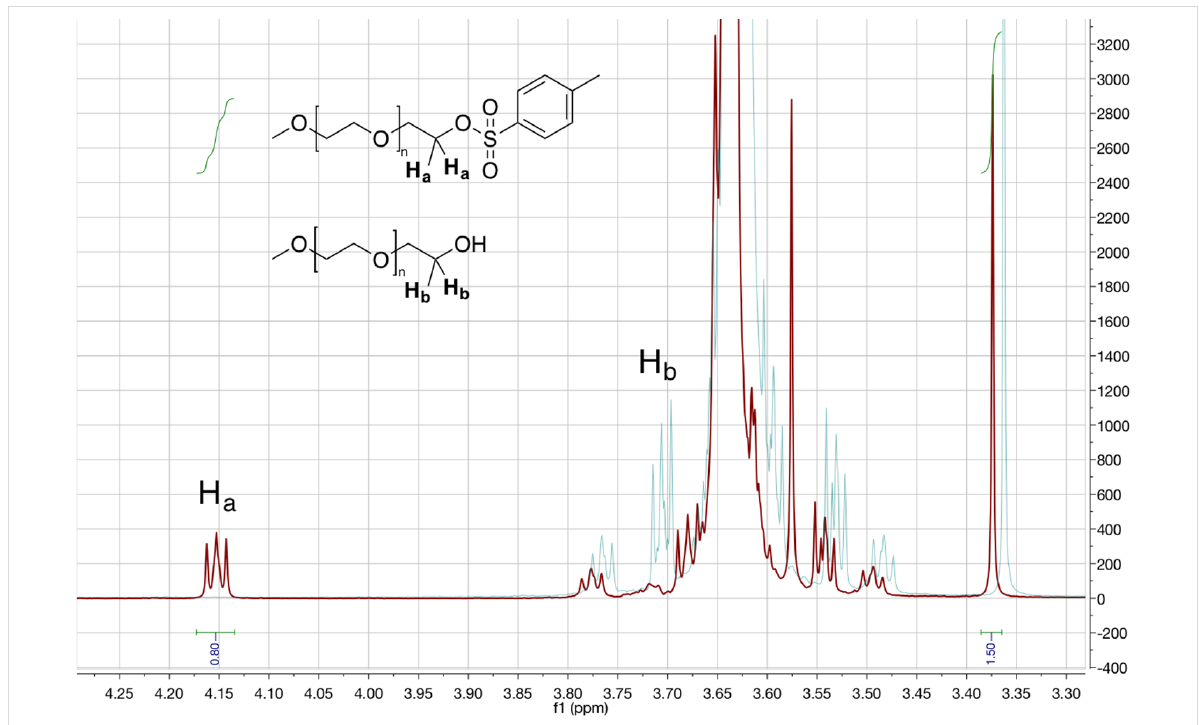
Figure 1: 1 H NMR of sample mPEG 2000 –OTs (Table 1, entry 5) in CDCl 3 showing mPEG end group shift after tosylation.